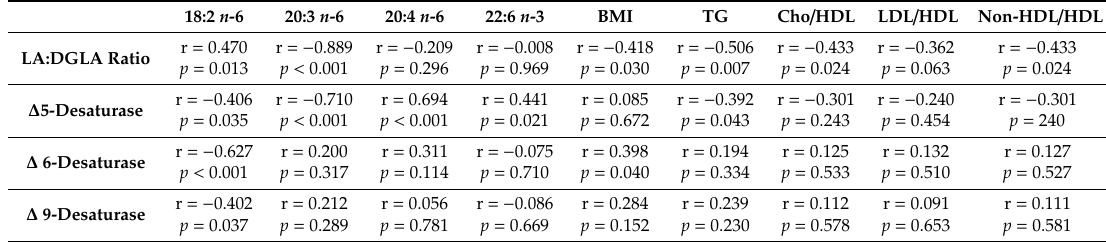
Table 5. Correlations between LA:DGLA ratio and desaturase activities with the status of individual plasma fatty acids, BMI, and biochemical parameters in study